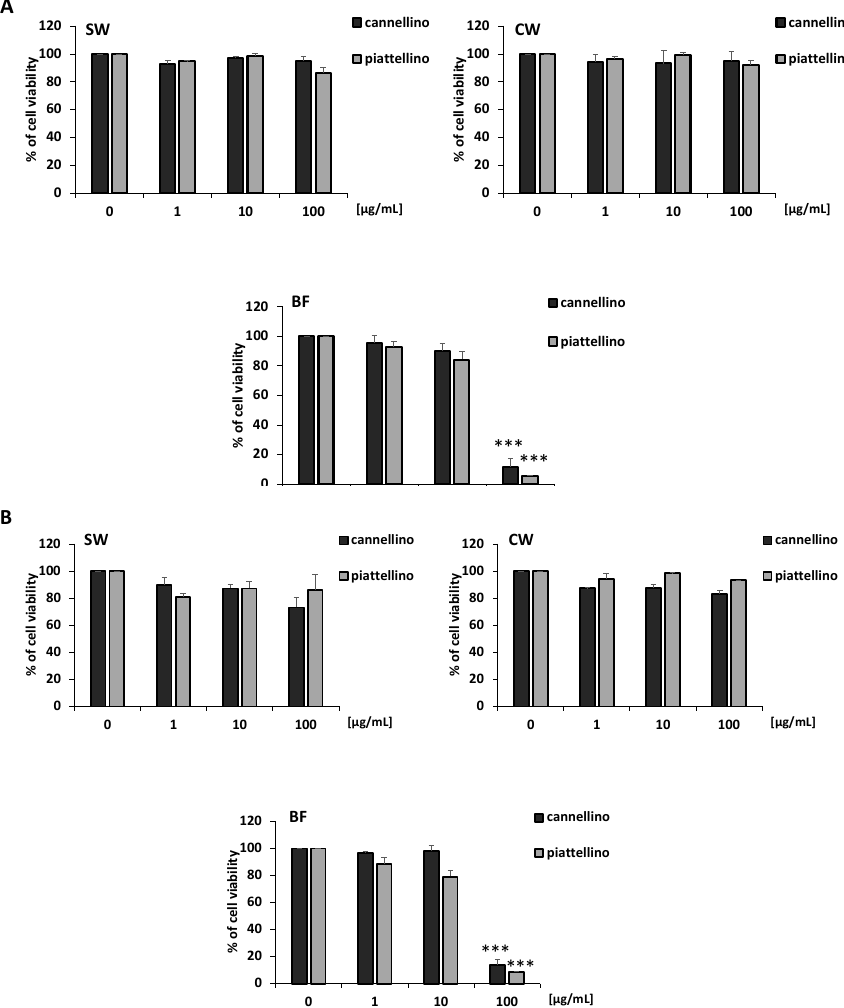
Figure 3. The bioaccessible fraction of cooked beans (BF) inhibits colon cancer cell vitality. Cell vitality was measured in the presence or absence of Cannellino and Piattellino extracts (1, 10 and 100 µ g/mL) by MTT assay. HT29 ( A ) and HCT116 ( B ) cells were exposed to treatments for 48 h. Data are reported as % of cell viability and are the means of three experiments run in triplicate. *** p < 0.0001 vs. basal.